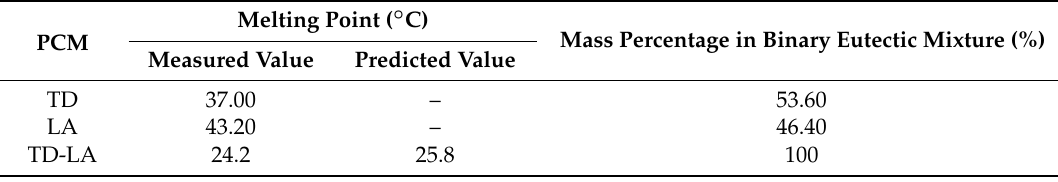
Table 2. Comparison of measured and calculated melting temperatures and mass percentages for TD and LA. Melting Point ( ◦ C) Mass Percentage in Binary Eutectic Mixture (%) PCM Measured Value Predicted Value TD